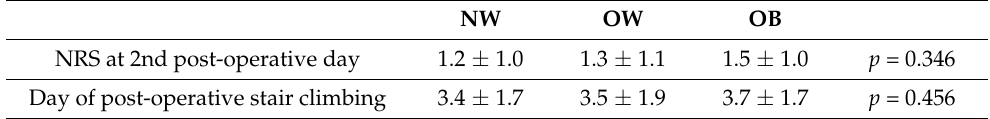
Table 3. Secondary clinical parameters.